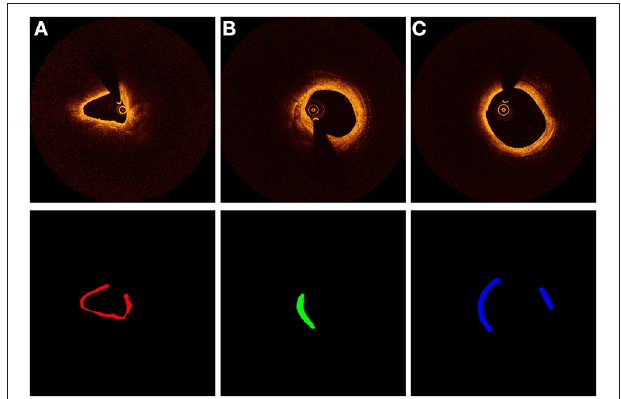
FIGURE 1 | Characterization of coronary plaque components from OCT images. Different colors represent different plaque composition: (A) red: fibrous. (B) green: calcified, (C) blue: